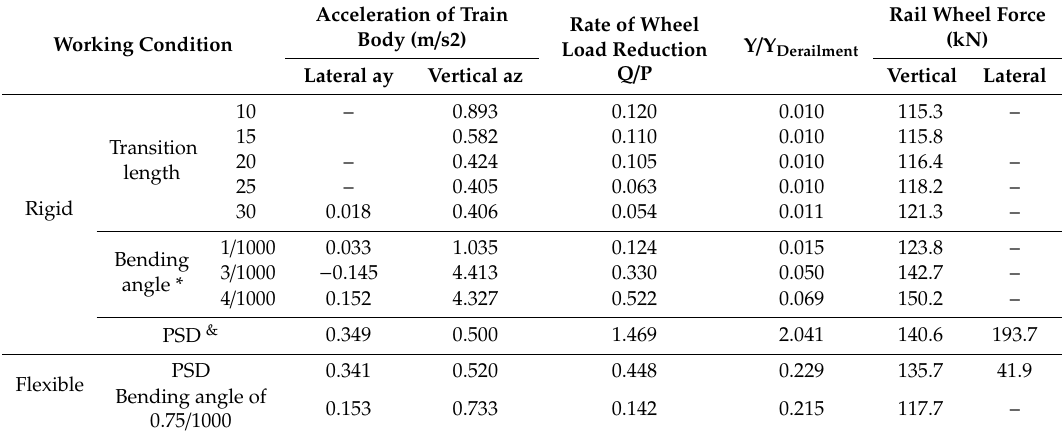
Table 1. Comparison of dynamic performance of four kinds of vehicles with irregularities.